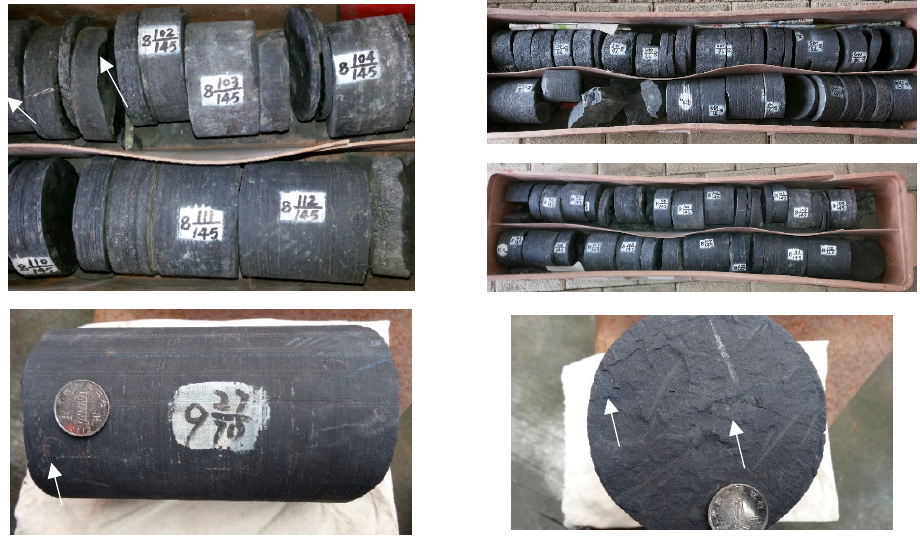
Figure 2. Calcite-filled fracture in downhole cores of Longmaxi Formation in Fuling.